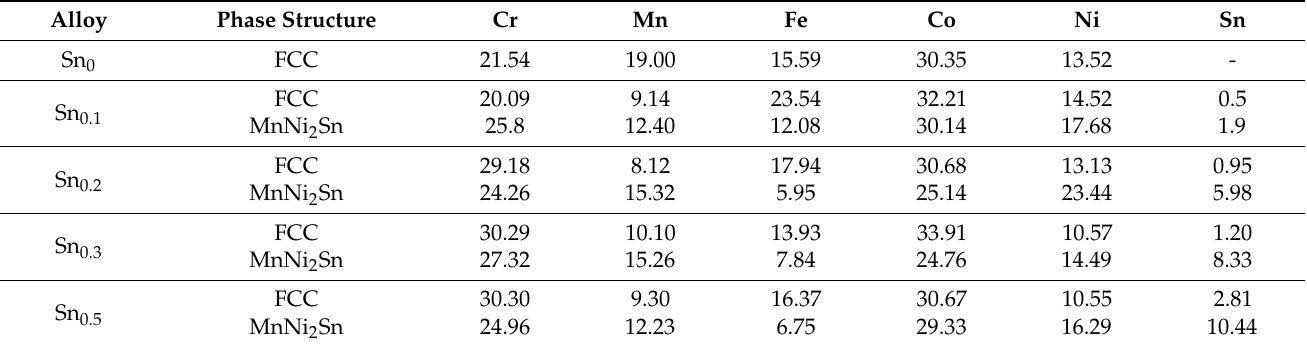
Table 2. Chemical composition of each phase of CoCrFeNiMnSn x HEA coatings